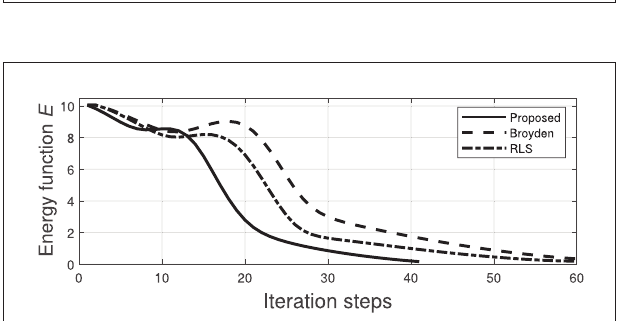
FIGURE 9 | Initial and final configurations of the shape control simulation with two robots.